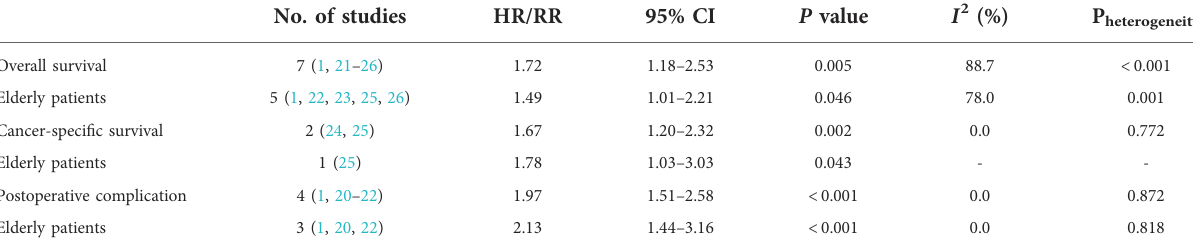
TABLE 2 Results of meta-analysis.